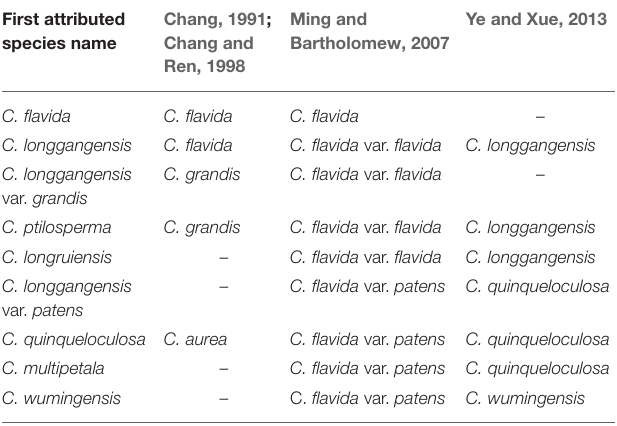
TABLE 1 | Previous researchers’ classifications of C. flavida